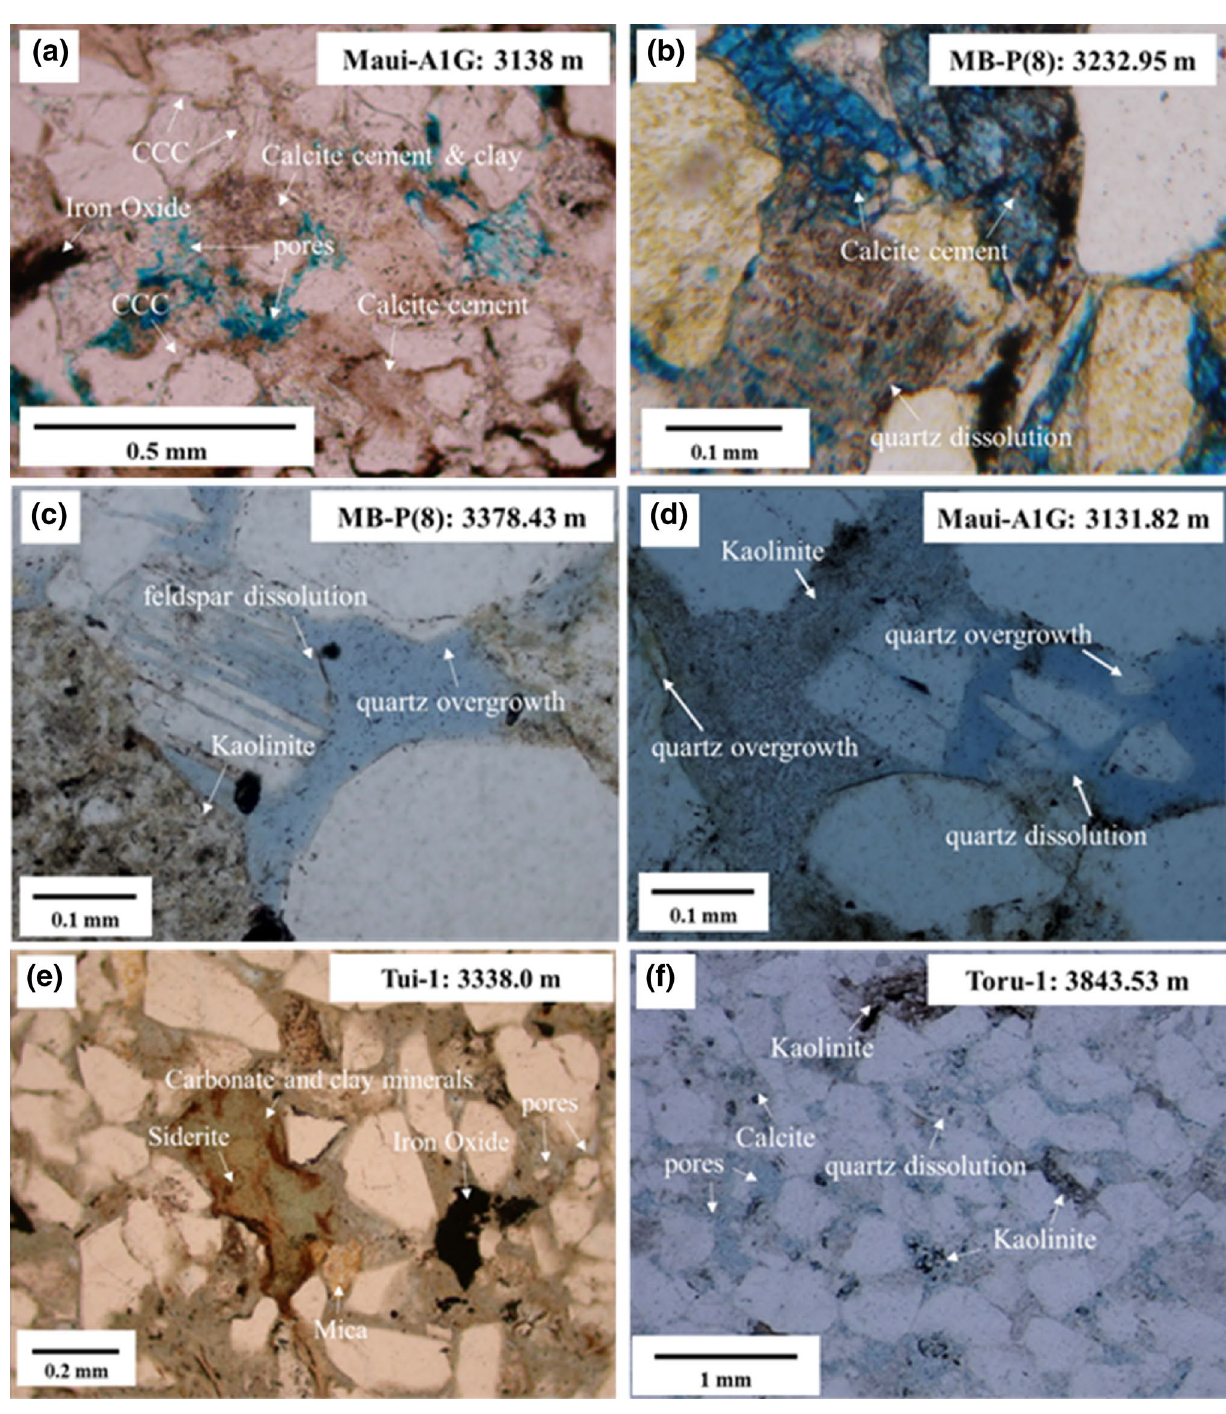
Fig. 7 Thin section photomicrographs of medium- to fine-grained Kaimiro sandstone. Other features are observed in the selected sam- ple data: a concavo-convex contacts (CCC), clay and calcite cement, along with iron oxide filling pores; b quartz dissolution and carbon- ate cement (stained bright blue); c feldspar dissolution, quartz over-